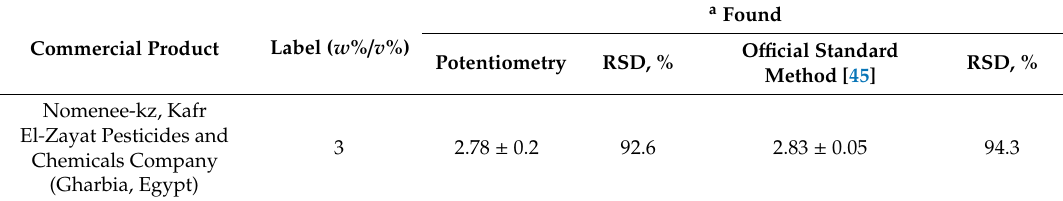
Table 3. Determination of CYR in commercial pesticide formulation using MIP / PANI-SCISE. Commercial Product